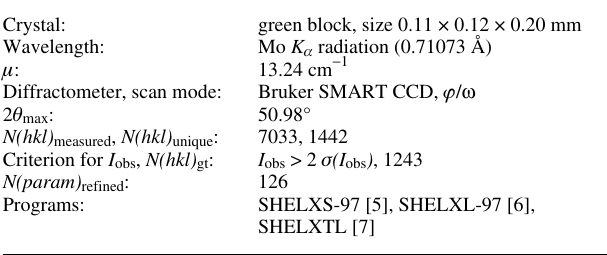
Table 1. Data collection and handling.